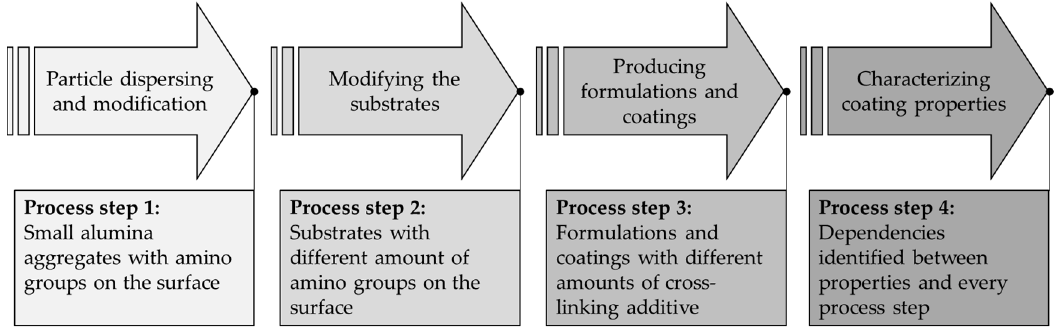
Figure 2. Process chain to produce covalently linked particle coatings on modified substrates.